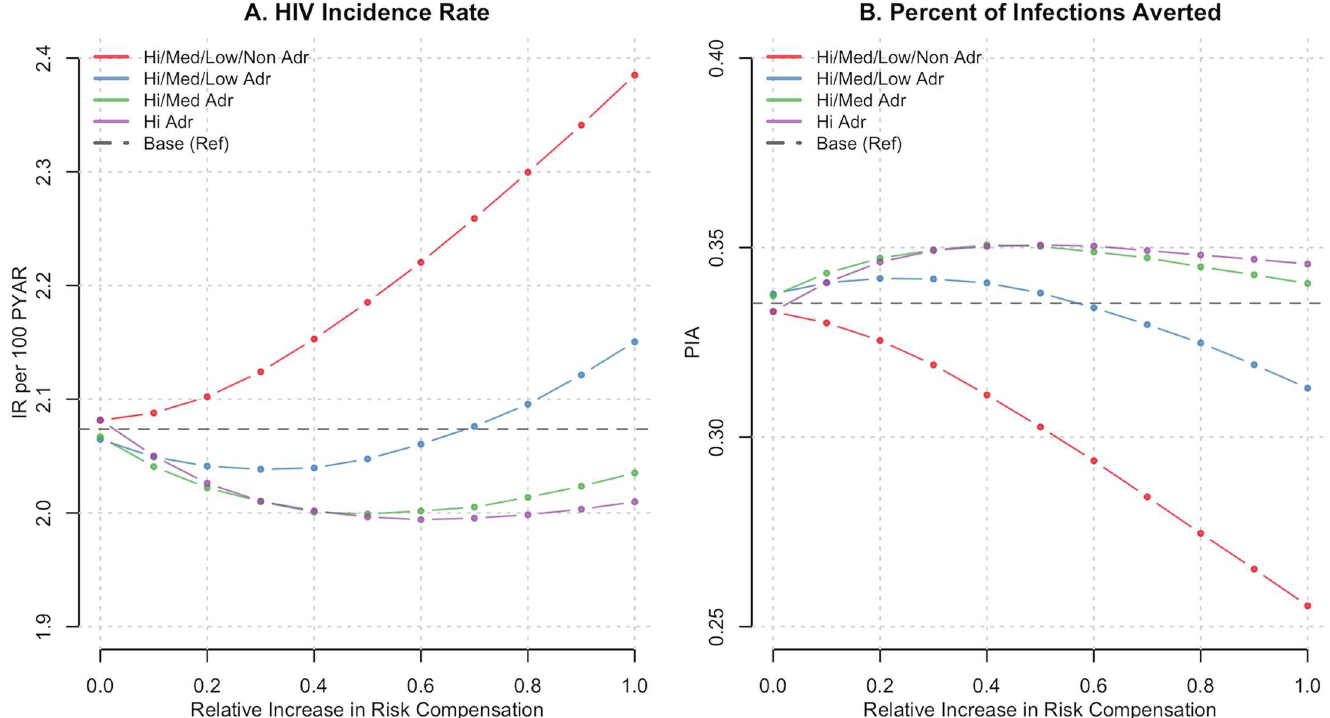
Fig 1. The HIV incidence rate per 100 person-years at risk (Panel A) and percent of infections avertedrelative to a scenario in which no PrEP was used (Panel B), by the interaction of relative levels of condom-related risk compensation (RC) and PrEP adherence profile in which compensation occurred. The red line depicts RC in all four PrEP medicationadherence profiles (high, medium, low, and non-adherent), the blue in the top three (high, medium, low) green in the top two (high and medium)and purplein the high only. The horizontaldashedlines shows a comparison of the two outcomes(incidenceand PIA) if RC were not to occur (0% RC). All points summarize the empiricaldistribution of 250 simulations of each scenario.